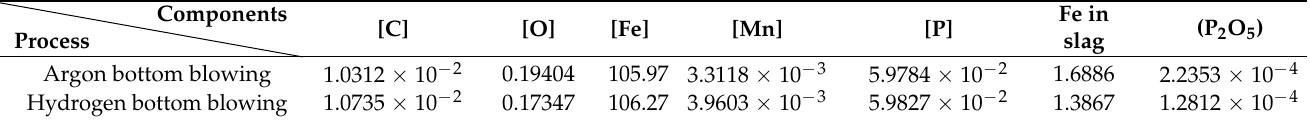
Table 16. Mass of some components in late periods of the two types steelmaking processes